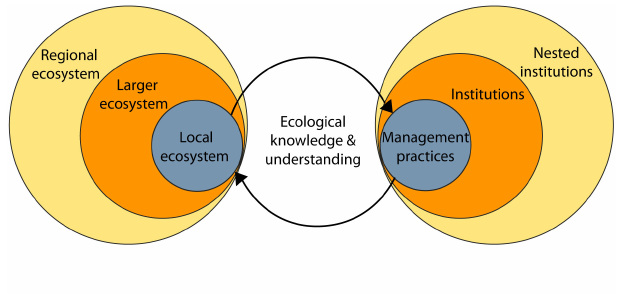
Fig. 1 . A conceptual framework for the analysis of linked social-ecological systems. Ecological knowledge and understanding is a critical link between complex and dynamic ecosystems, adaptive management practices, and